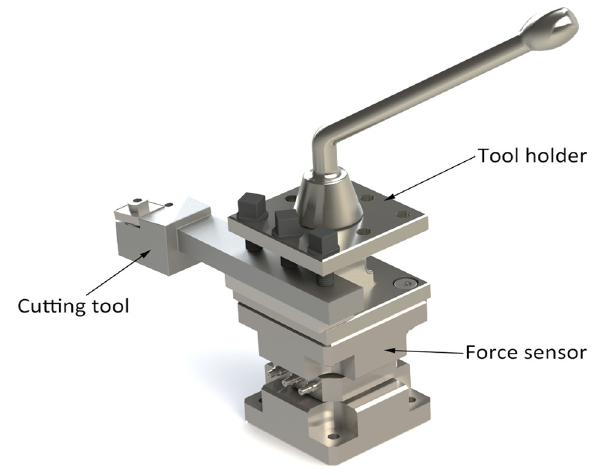
Figure 4. The system used to measure cutting forces.